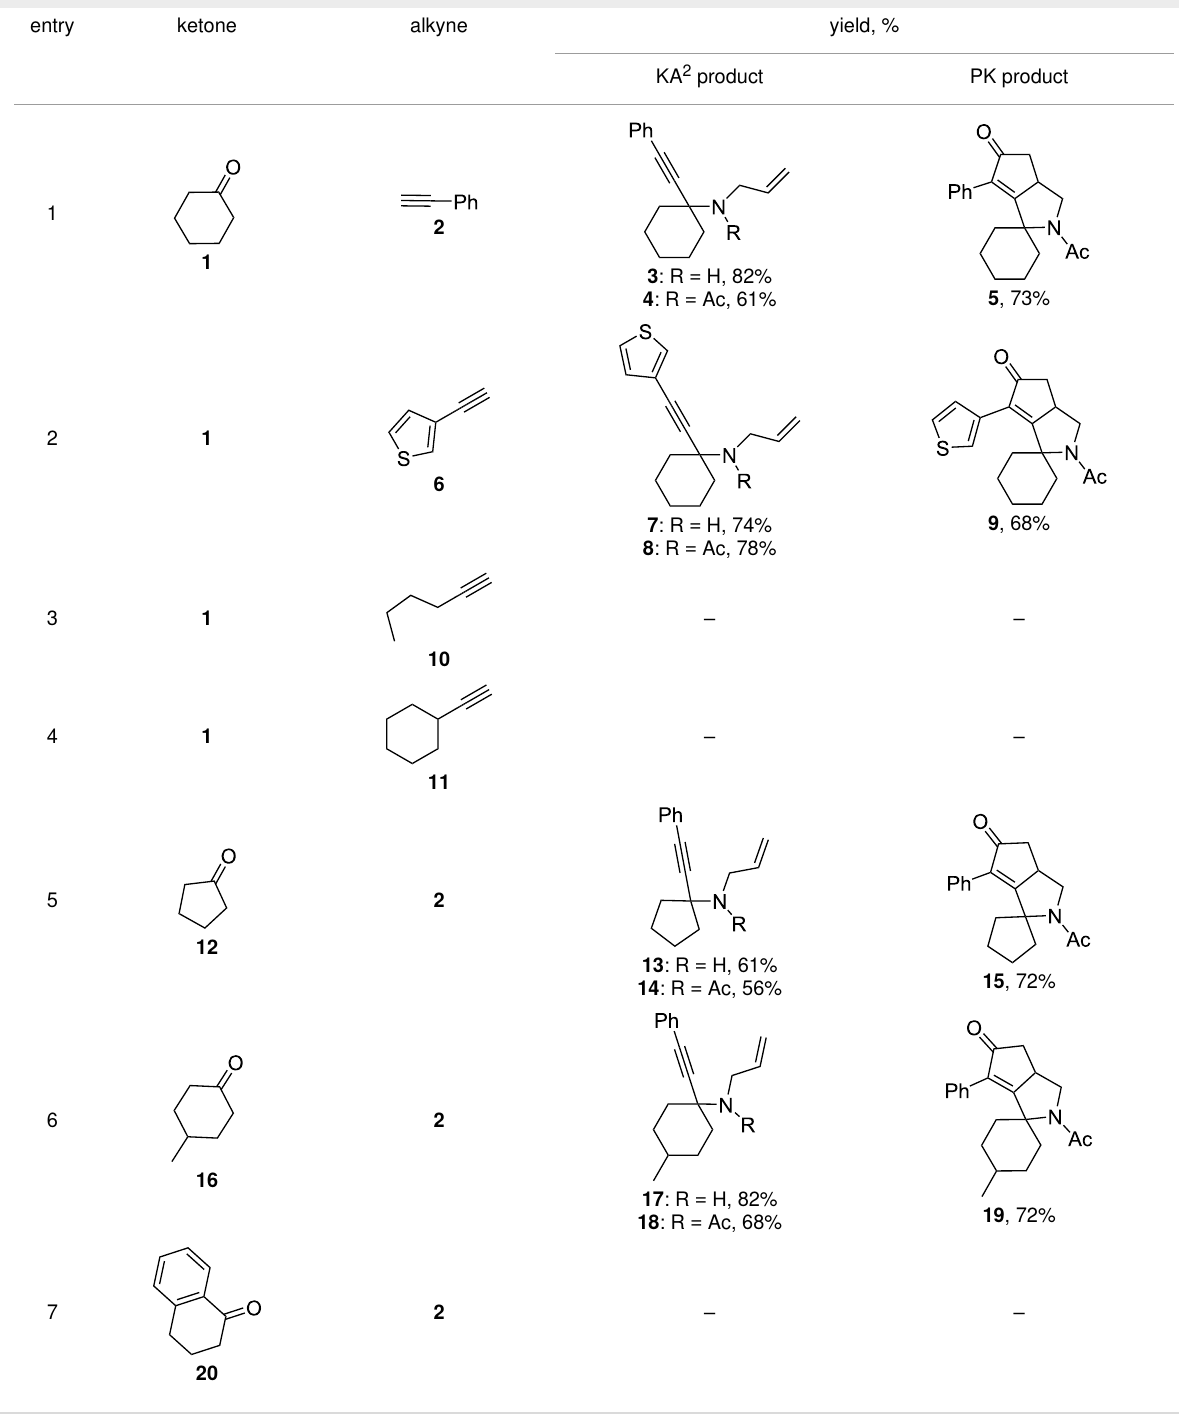
Table 1: Scope of the combined KA 2 and Pauson–Khand multicomponent processes. a